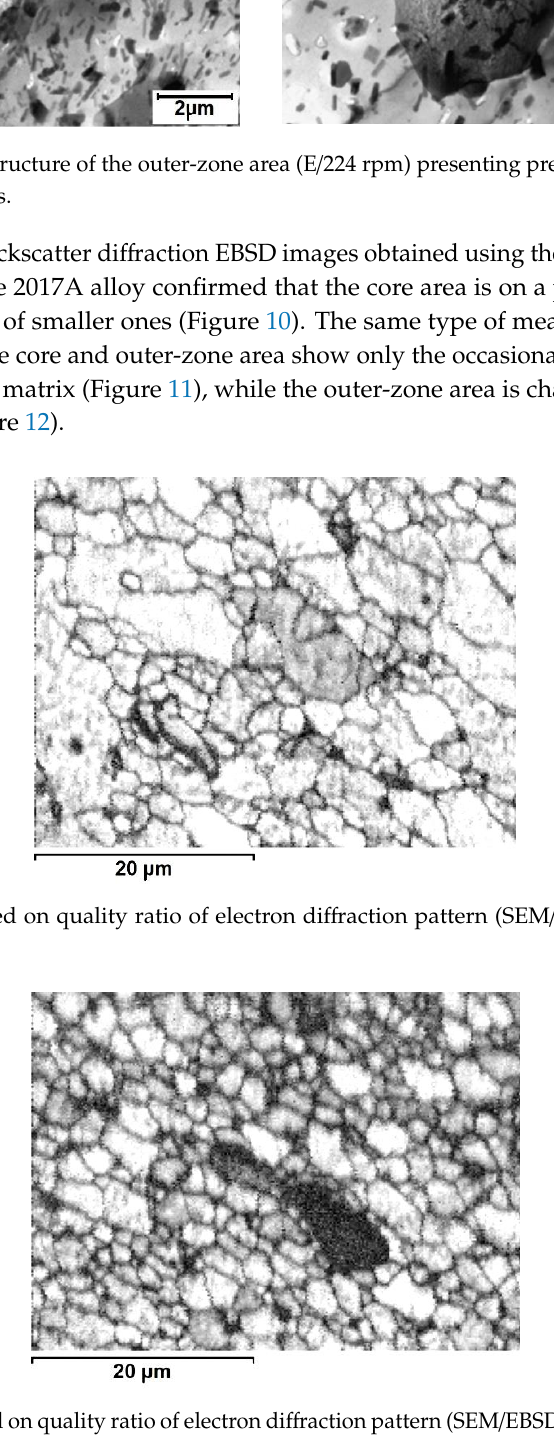
Figure 11. Image based on quality ratio of electron di ff raction pattern (SEM / EBSD) from core / outer-zone area boundary (E / 224 rpm).